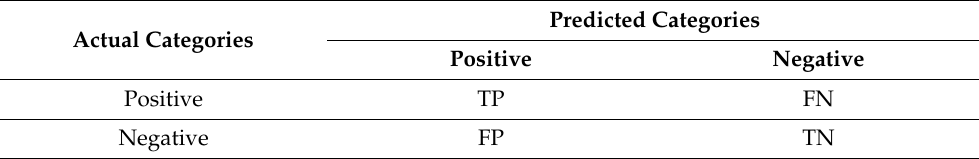
Table 2. Explanatory table for evaluation indicators.